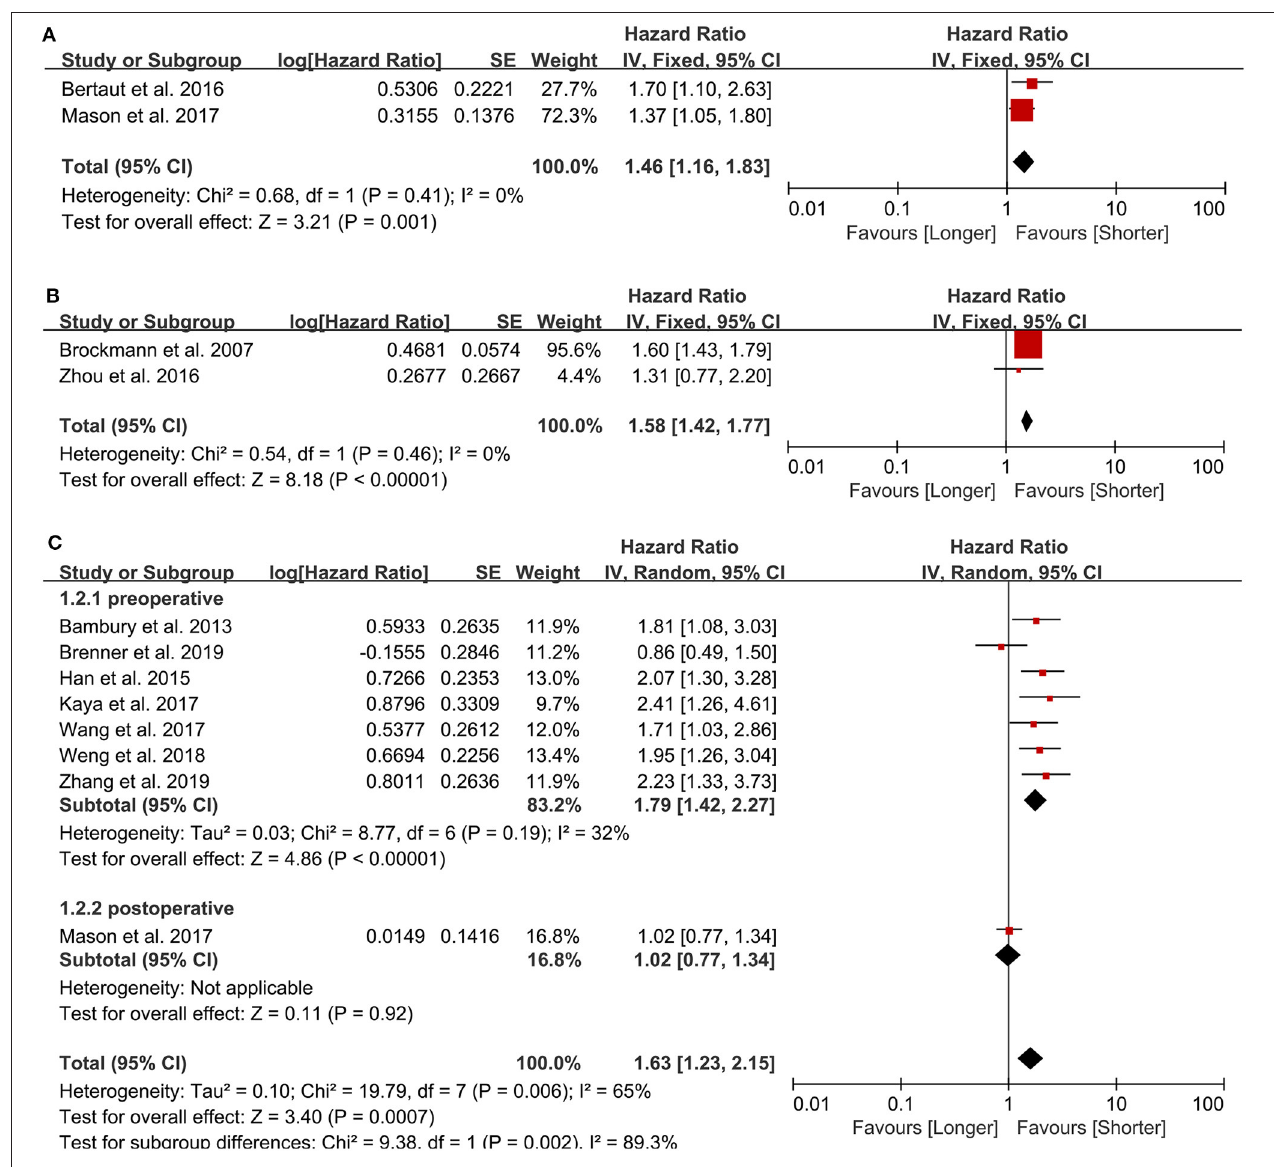
FIGURE 2 | Pooled hazard ratio (HR) and 95% confidence intervals (CIs) for OS in GBM patients. (A) HR and 95% CIs of the count of neutrophils. An elevated neutrophil count predicted a poor prognosis in GBM patients. (B) HR and 95% CIs of the count of platelets. Elevated platelets also predicted a bad outcome in patients with GBM. (C) HR and 95% CIs of NLR. A higher NLR predicted a worse prognosis in GBM patients either in total group analysis or pre- and post-operative subgroup